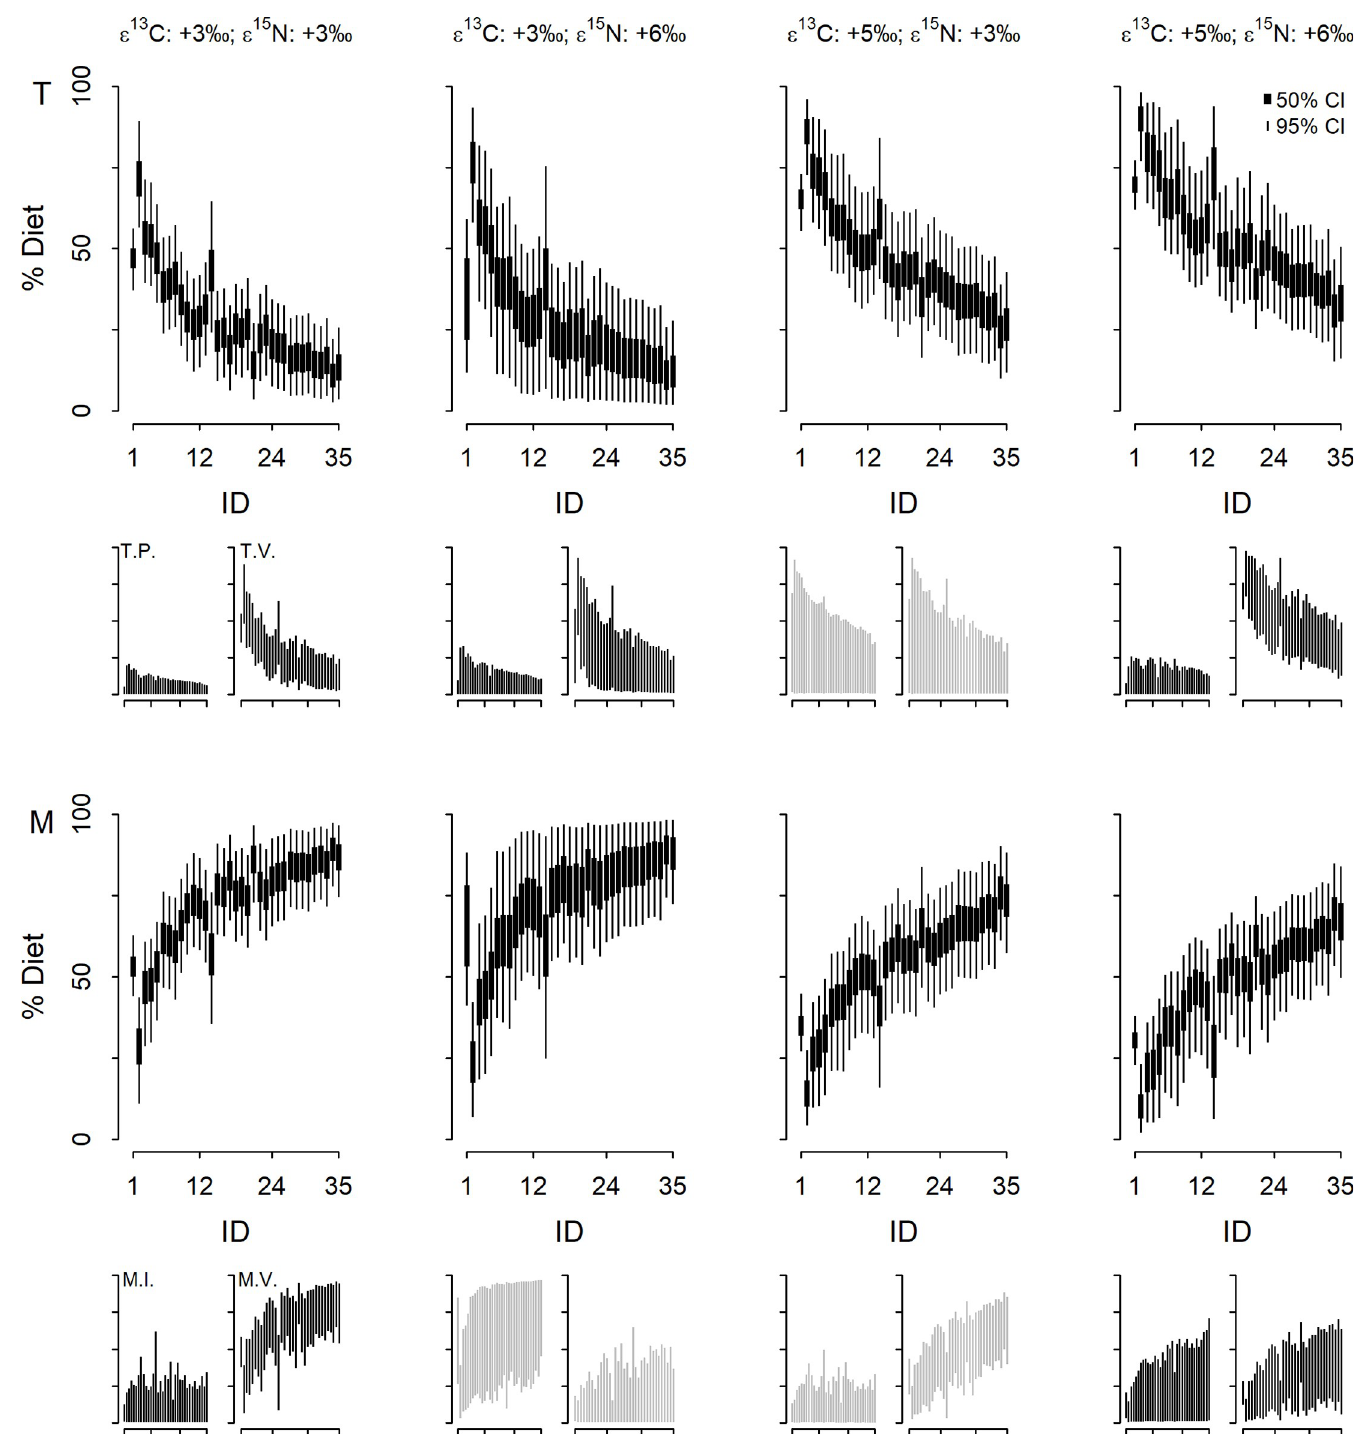
Fig 5. Contributions of food groups to diets of Later Stone Age humans on the Cape Peninsula. Plots in each column correspond to those in the first column labelled according to food type. Line segments in larger graphs denote credible intervals as indicated in the legend (top-right), generated using Bayesian stable isotope mixing models. Smaller graphs show only 95% CI on the same sets of axes as those in larger graphs. Grey line segments indicate that foods in that row were indistinguishable for that model. ID numbers identify individual humans, arranged in order of δ 13 C values–increasing from left to right. T = terrestrial foods, T.P. = terrestrial plant foods, T. V. = terrestrial vertebrate foods, M = marine foods, M.I. = marine invertebrate foods and M.V. = marine vertebrate foods.